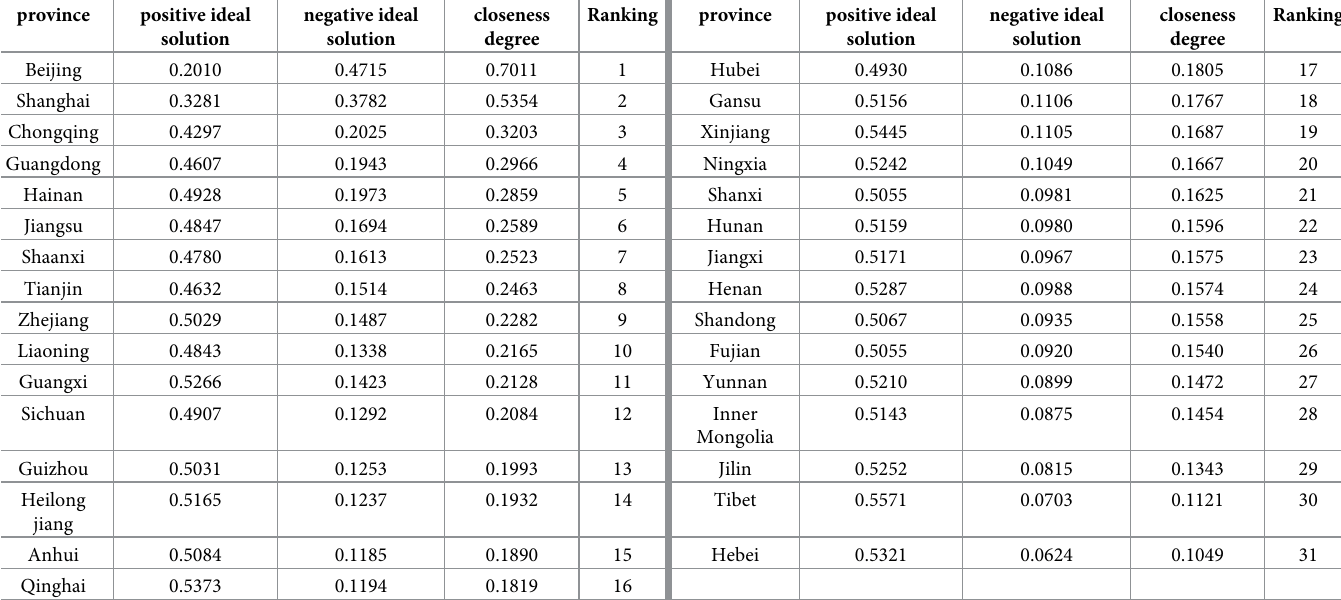
Table 3. Ranking of provincial innovation concentration.